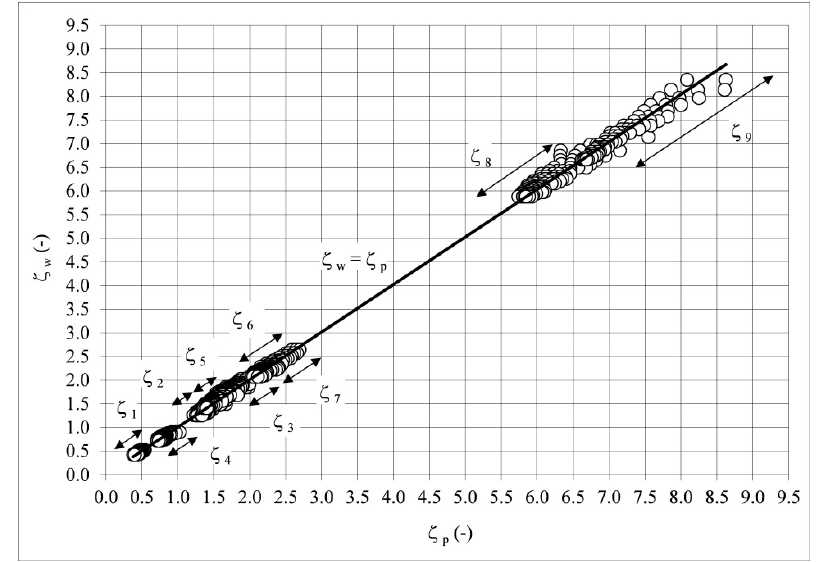
Figure 7. Verification of the correctness of the exponential mathematical model for calculations of the local resistance coefficient ζ .